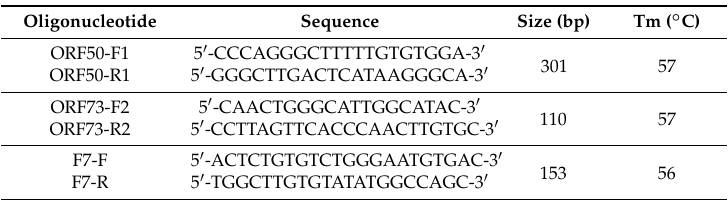
Table 2. Oligonucleotides used to detect Felis catus gammaherpesvirus 1 transcripts in feline immunodeficiency virus -associated lymphoma by